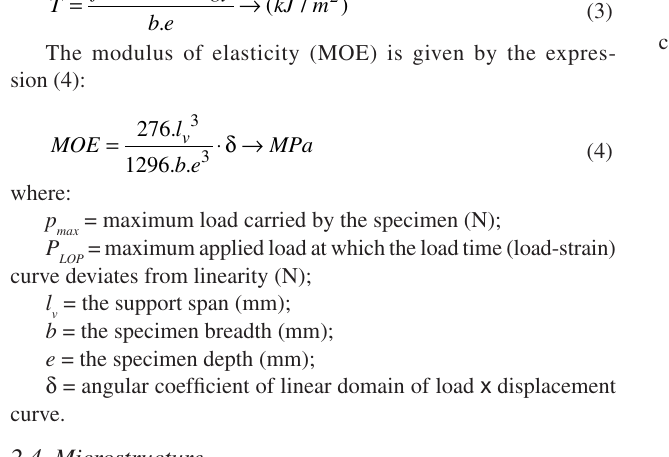
Figure 6. Pseudo-adiabatic calorimeter – equipment used in the laboratory to study the kinetics of gypsum hydration.